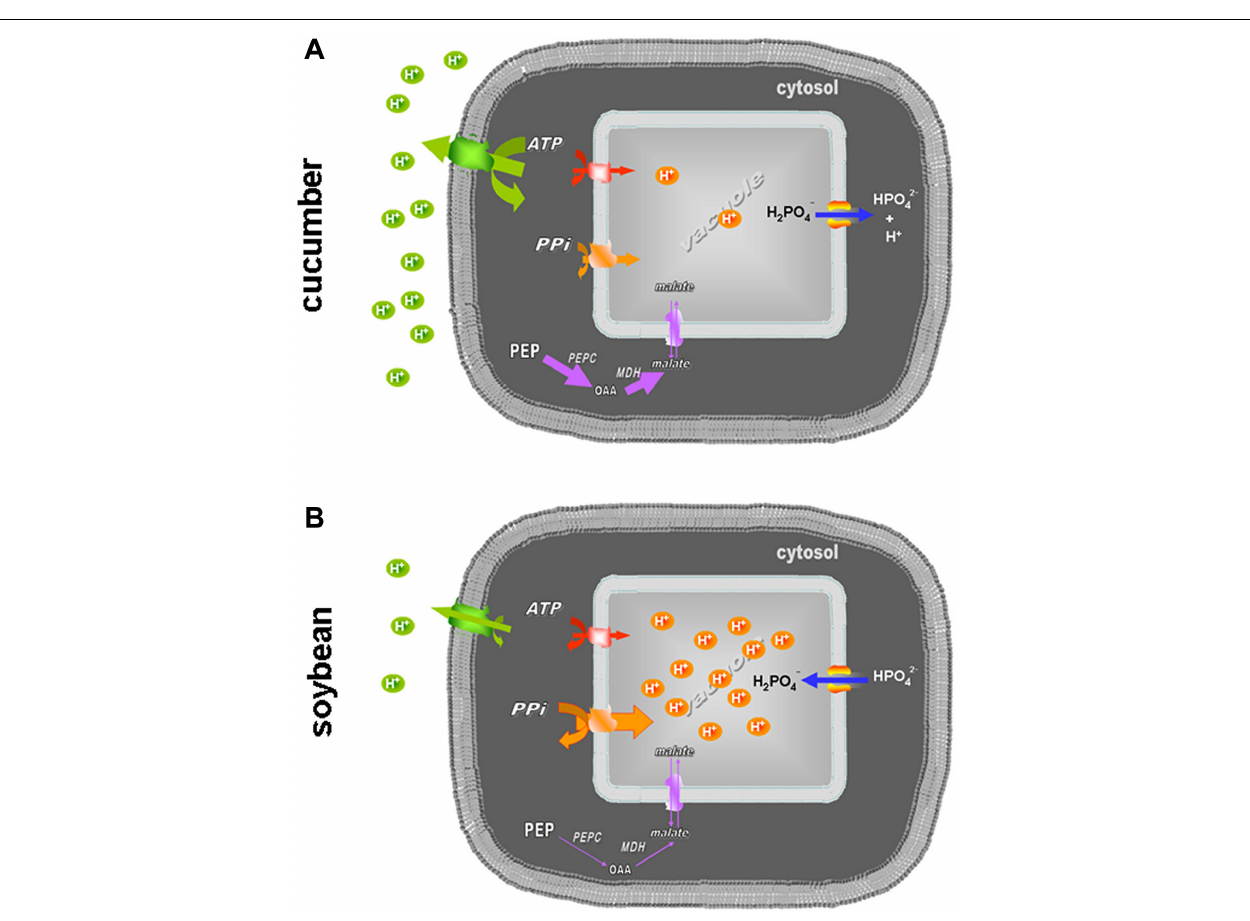
FIGURE 4 | Representation of the different roles of the vacuolar proton pumps and Pi movements across the tonoplast in cucumber (A) and soybean (B) roots under Fe deficiency. The activities of the PM-ATPase,V-ATPase,V-PPase, and PEPC are visualized as differently marked lines; the net Pi fluxes are described through the arrow